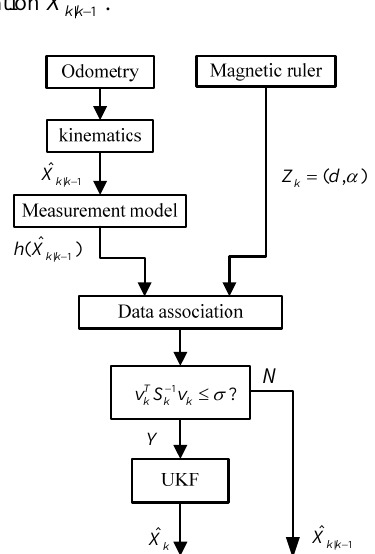
Fig. 4. Block Diagram of the Localization